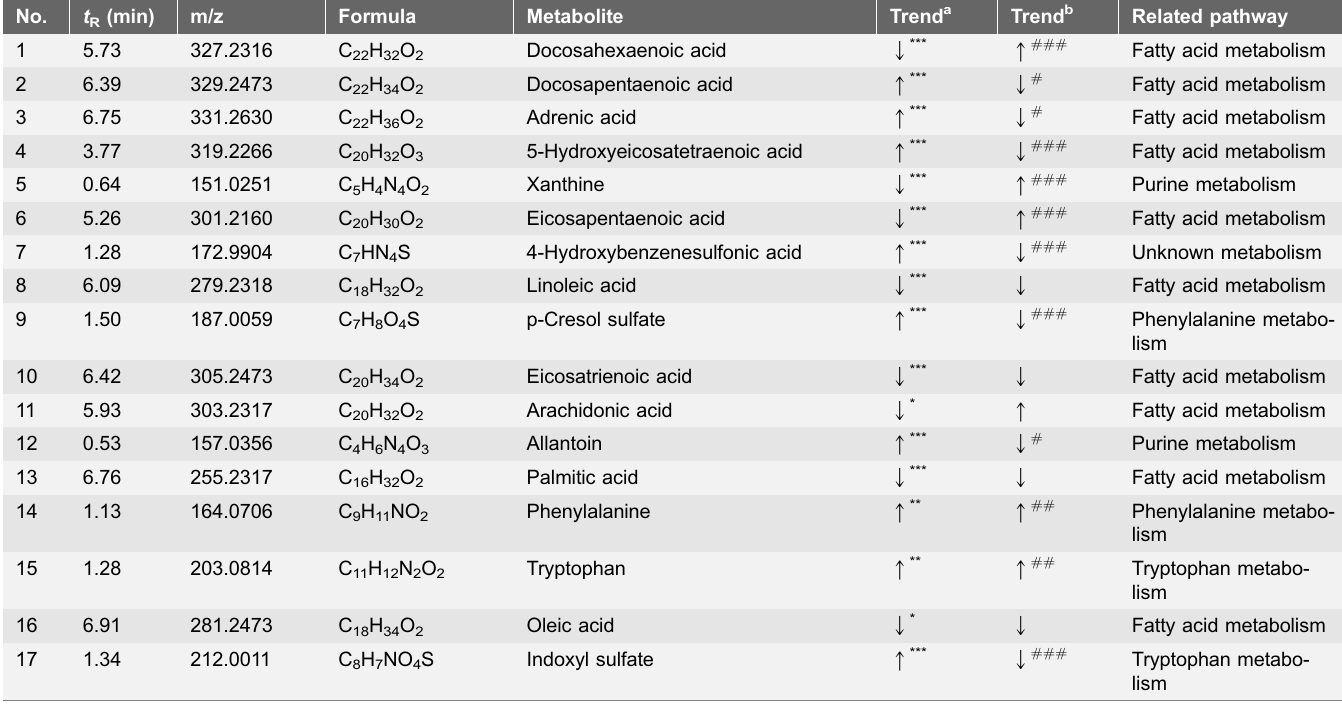
Table 2. Identification of significantly differential endogenous metabolites in the rat